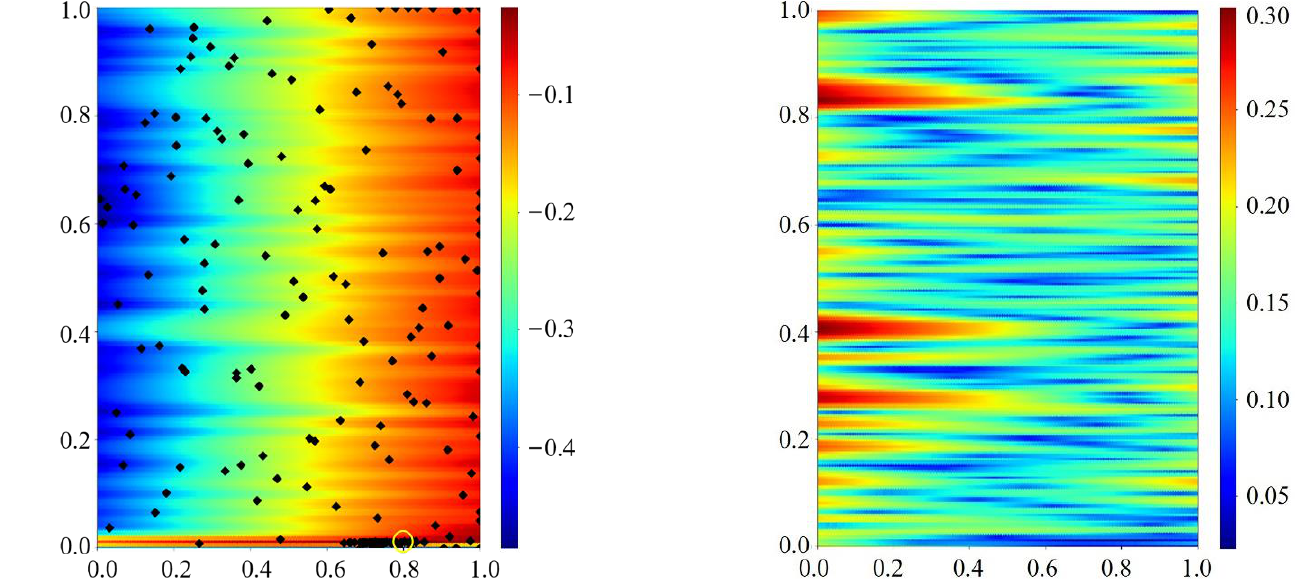
Figure A13. Two-parameter optimization process of 𝑎 and 𝑏 in the Houska model.